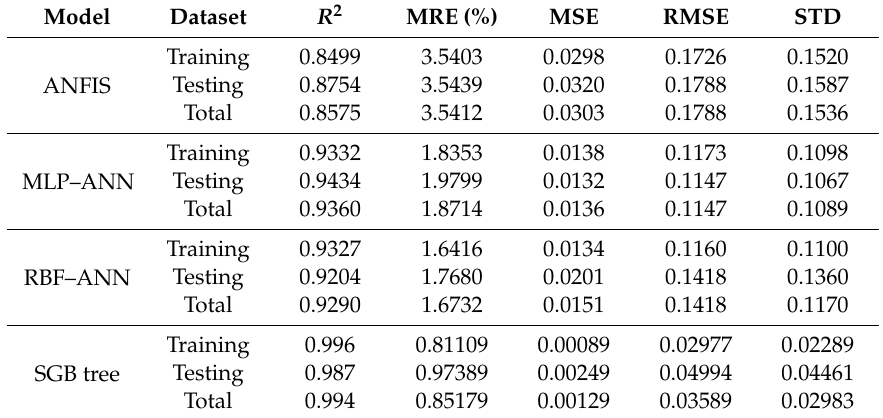
Table 3. Evaluating the performance of the proposed models using statistical